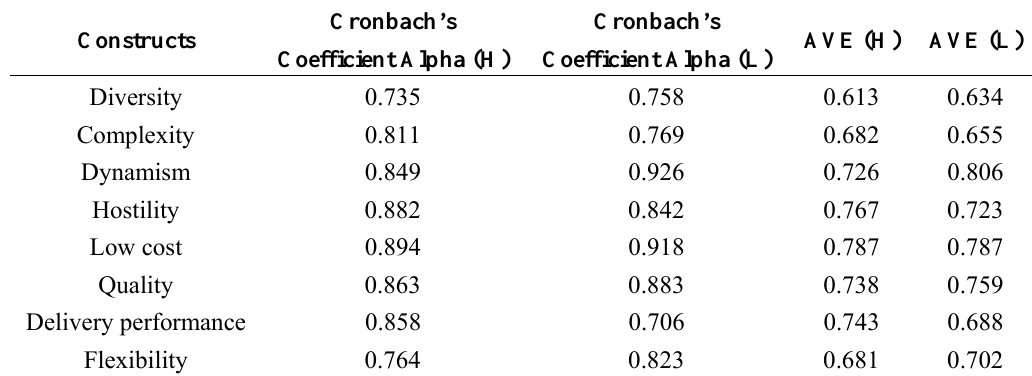
Table A3. Reliability and Convergent Validity Assessment.